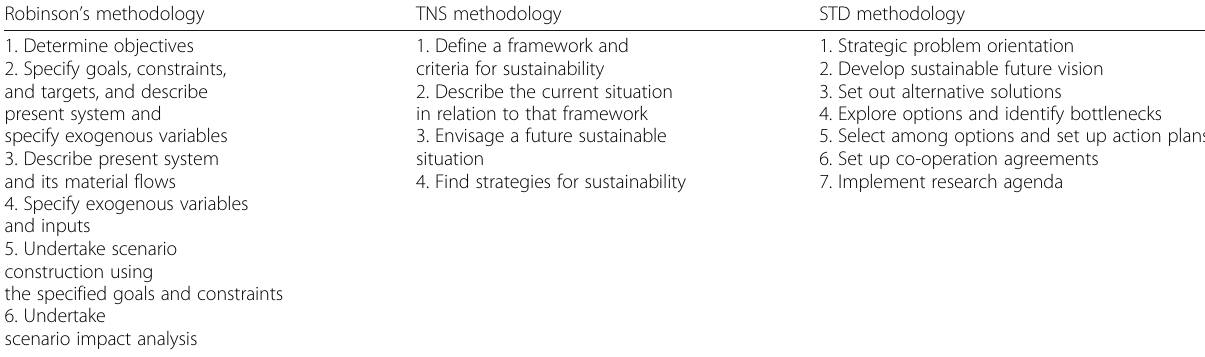
Table 2 Comparison of three backcasting methodologies Robinson ’ s